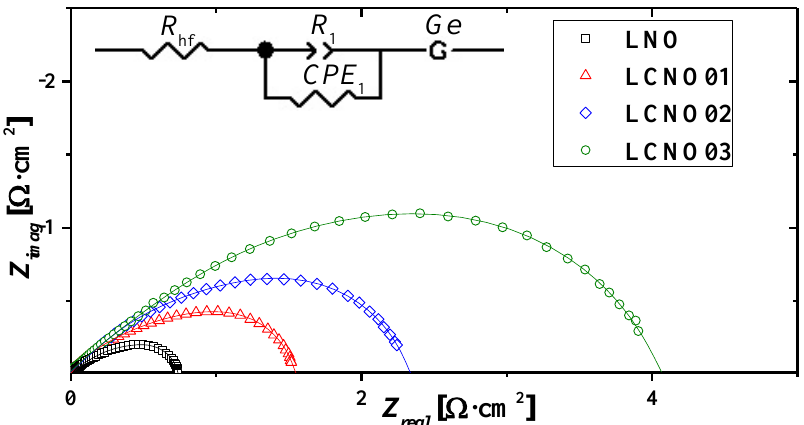
Figure 9. Typical Nyquist plots of impedance, obtained at 700 °С in air with electrolyte resistance subtracted.